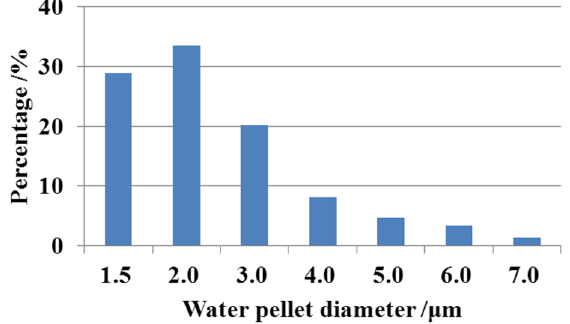
Figure 6 . Water pellet diameter distribution. Figure 6. Water pellet diameter